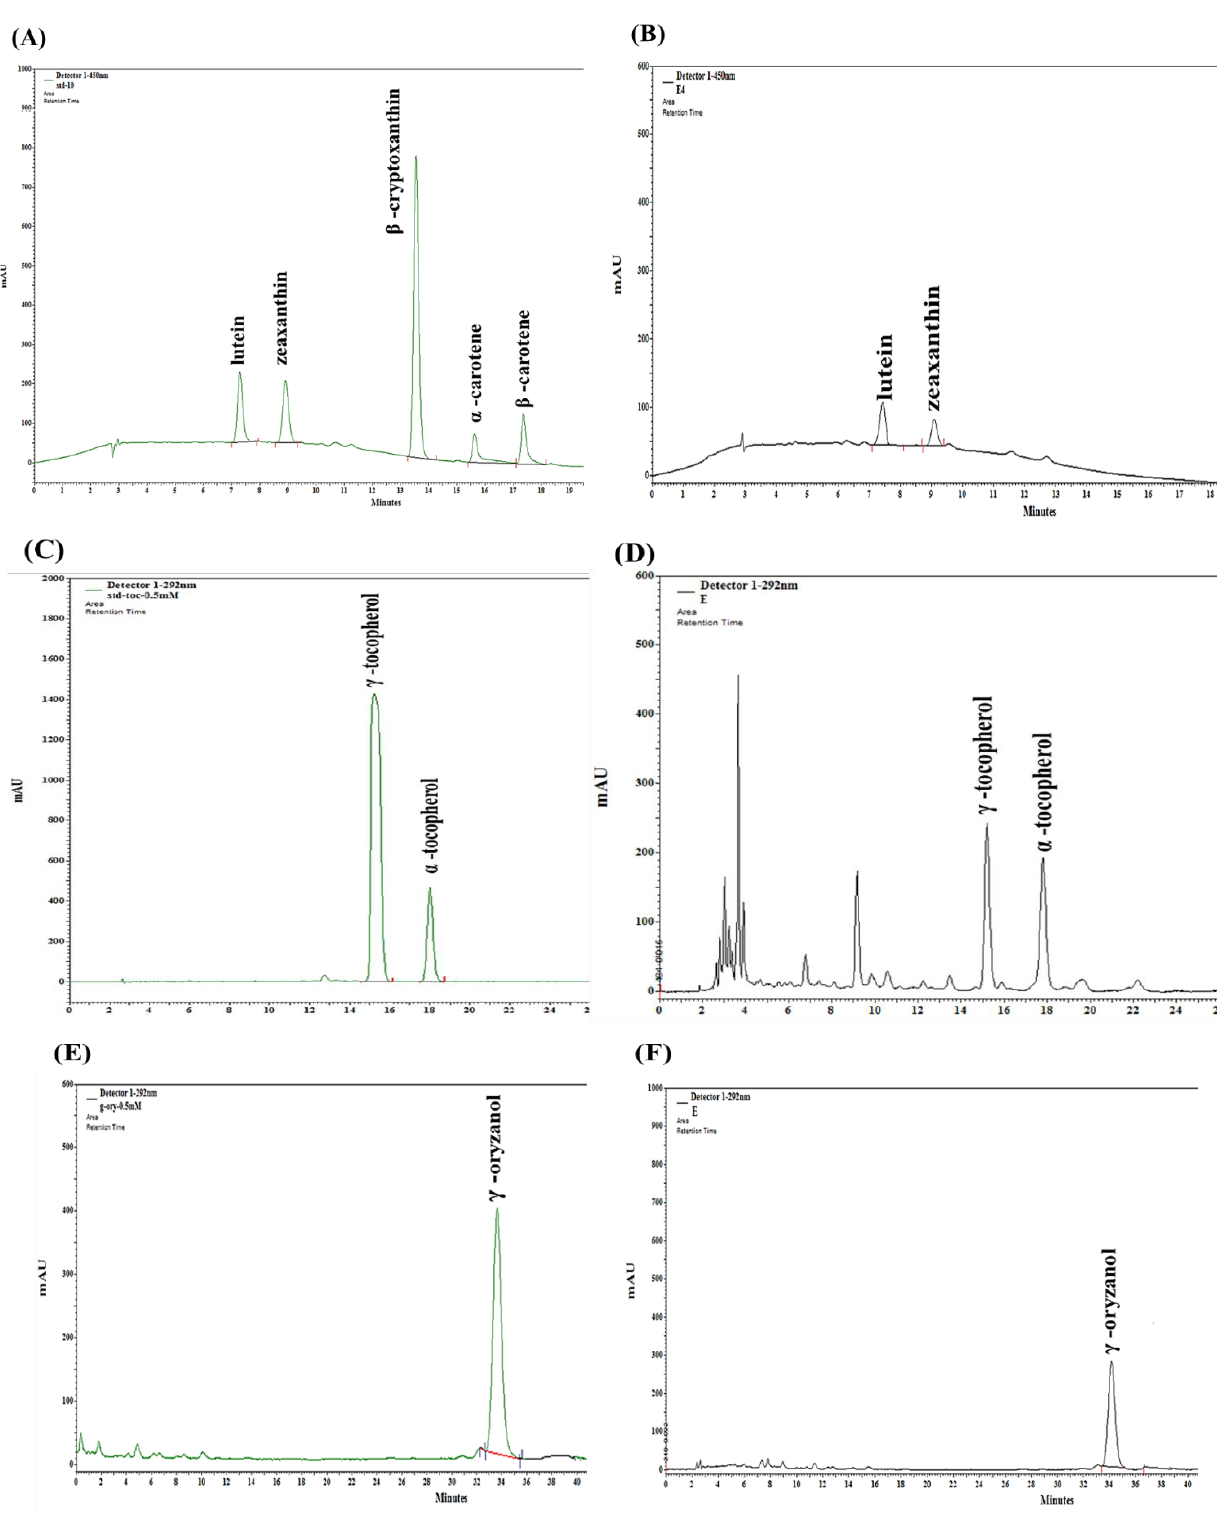
Figure 3. Representative HPLC chromatograms of bioactive compounds. ( A ) A standard mixture of all the analyzed carotenoids at λ = 450 nm. ( C ) A standard mixture of tocopherols at λ = 292 nm. ( E ) A standard mixture of γ-oryzanol at λ = 325 nm. ( B , D , F ) are representative chromatograms (ethanol extract) of carotenoids, tocopherols, and γ-oryzanol, respectively.